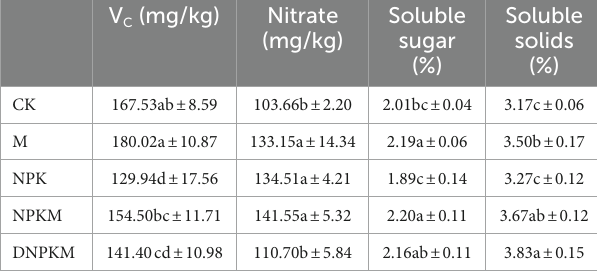
TABLE 4 The cucumber quality of each